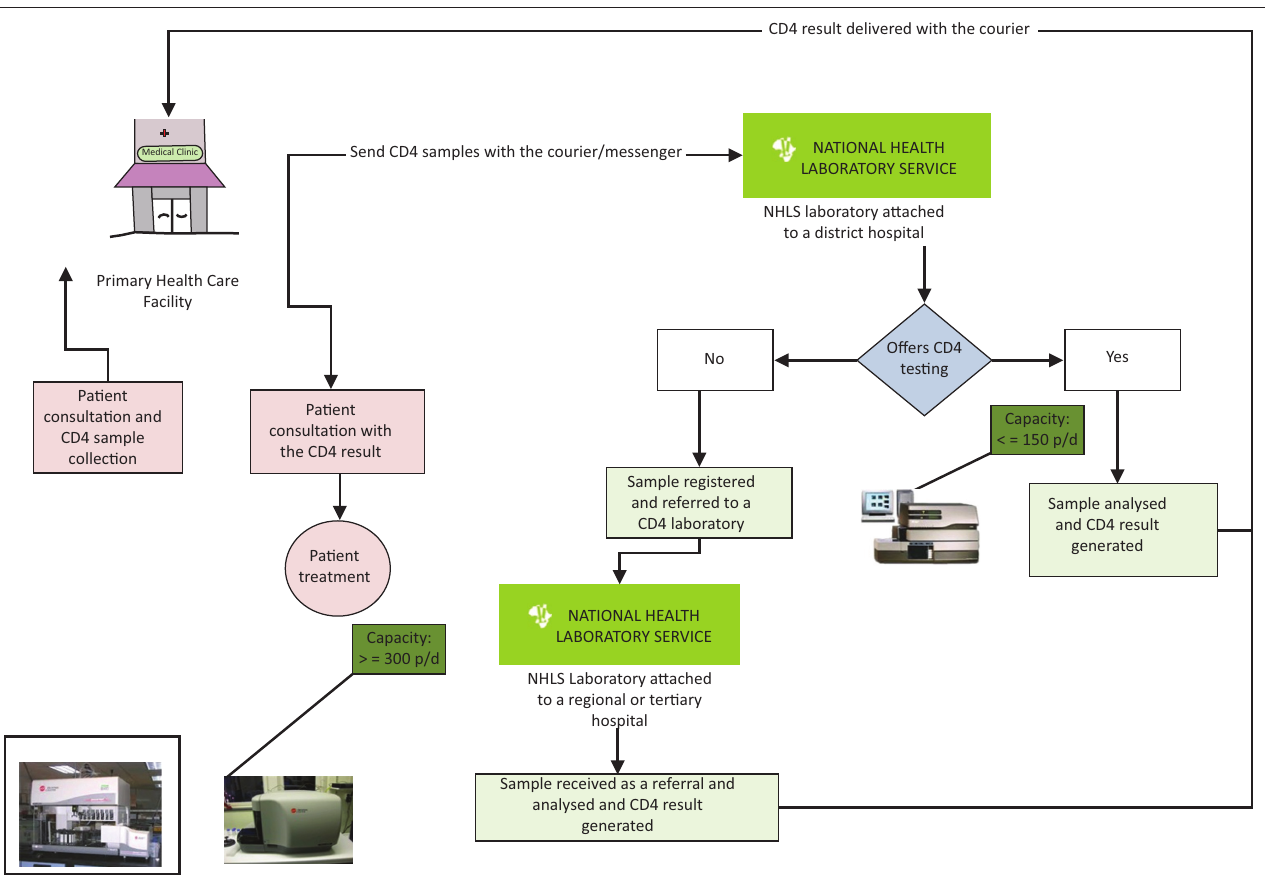
FIGURE 1: End to end process for CD4 samples from sample collection to using the result during the patient consultation.